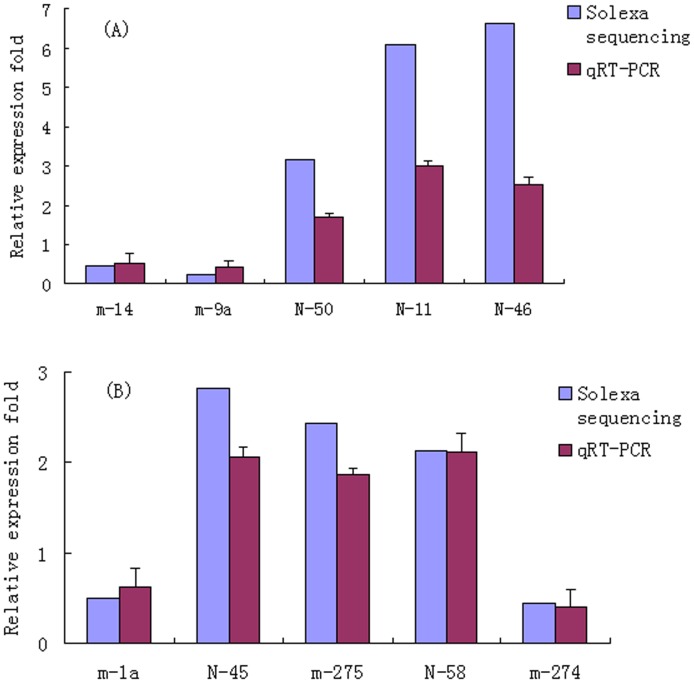
qRT-PCR results.(A) qRT-PCR confirming different expression of miRNA at BmCPV-infected 72 h, (B) qRT-PCR confirming different expression of miRNA at BmCPV-infected 96 h. Error bars represent standard deviation. qRT-PCR reactions were run in triplicates with 2 biological replicates.